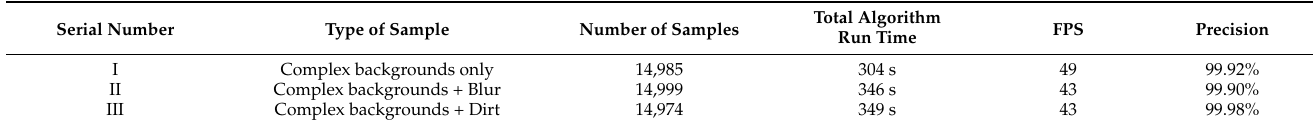
Table 5. Overall algorithm testing.